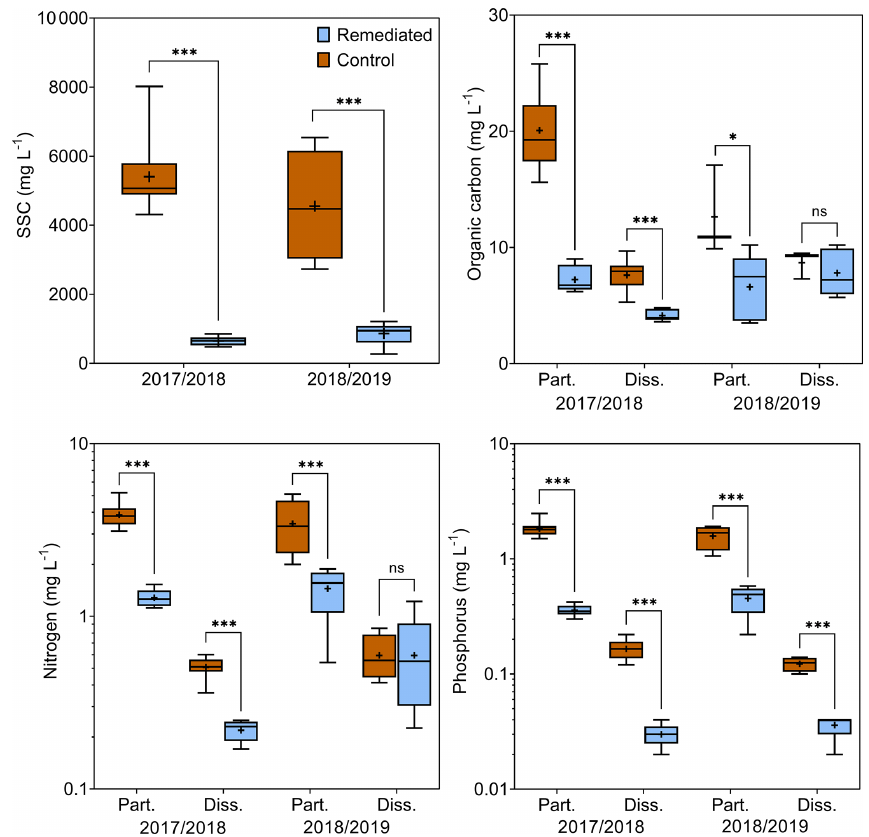
Figure 10. SSC and nutrient concentrations of samples collected during flow events in the 2017–2018 and 2018–2019 wet seasons. Note that the 2017–2018 data represent a single flow event, and the 2018–2019 data represent multiple flow events. Box plots represent the minimum, maximum, 25th and 75th percentiles, median (horizontal line in box), and mean (cross). Brackets above the box and whisker plots represent the results of paired t tests, where p < 0 . 001 ( ∗∗∗ ), p < 0 . 01 ( ∗∗ ), p < 0 . 05 ( ∗ ), or p > 0 . 05